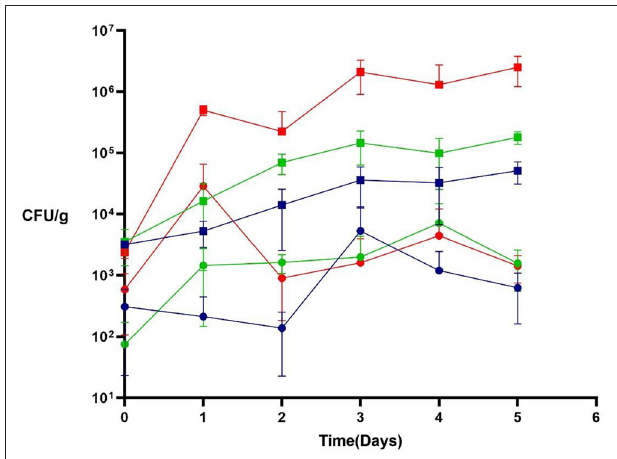
FIGURE 6 | Efficacy of phage P61 against deliberately-inoculated L. monocytogenes strain 702 on baby spinach leaves at 8 ◦ C (blue symbols), 12 ◦ C (green symbols), and 25 ◦ C (red symbols). L. monocytogenes were enumerated daily; squares represent untreated samples; circles represent phage-treated samples. Results are presented as mean values, and error bars represent standard deviations of the